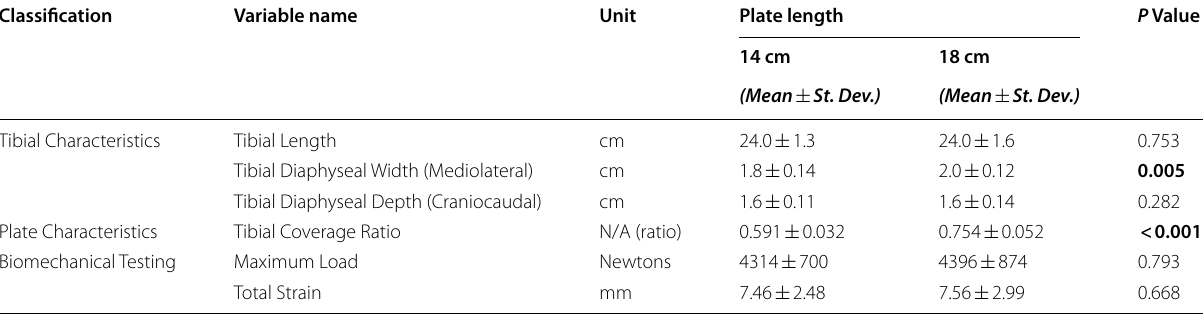
Table 1 Results of in vitro plate length analysis. Despite significant differences in tibia coverage ratio, no significant differences in maximum load or total strain were detected during axial compression to failure